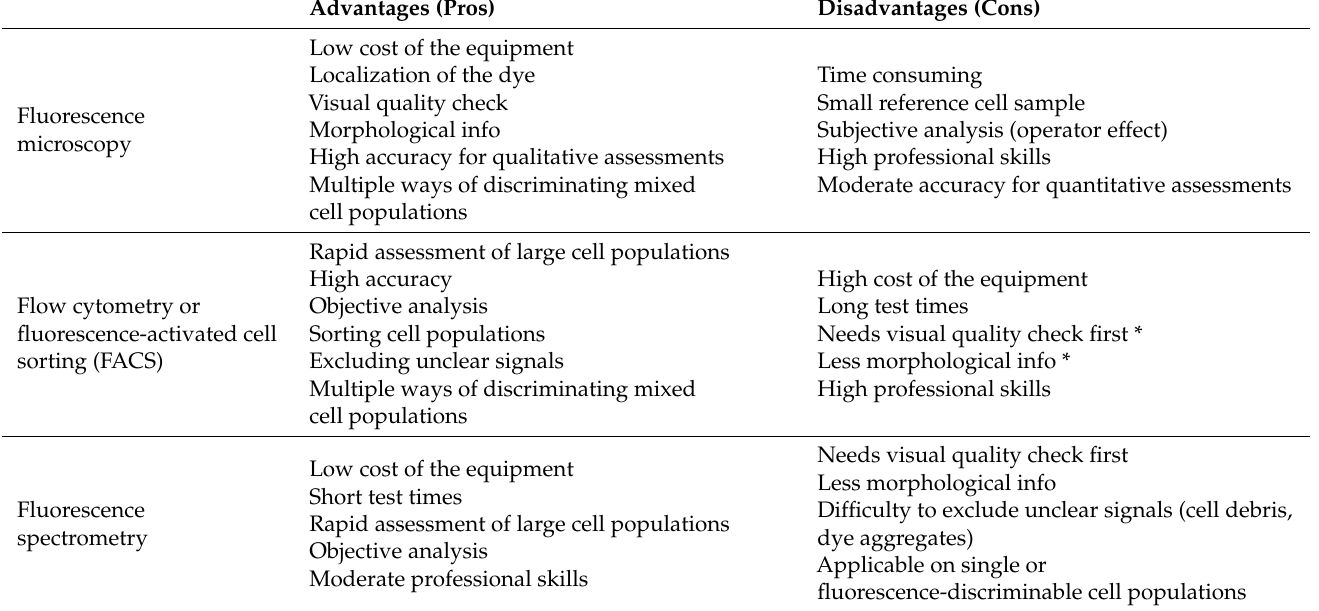
Table 5. Advantages and disadvantages in the use of fluorescence microscopy, flow cytometry, and fluorescence spectrometry techniques for the evaluation of sperm functional parameters. Advantages